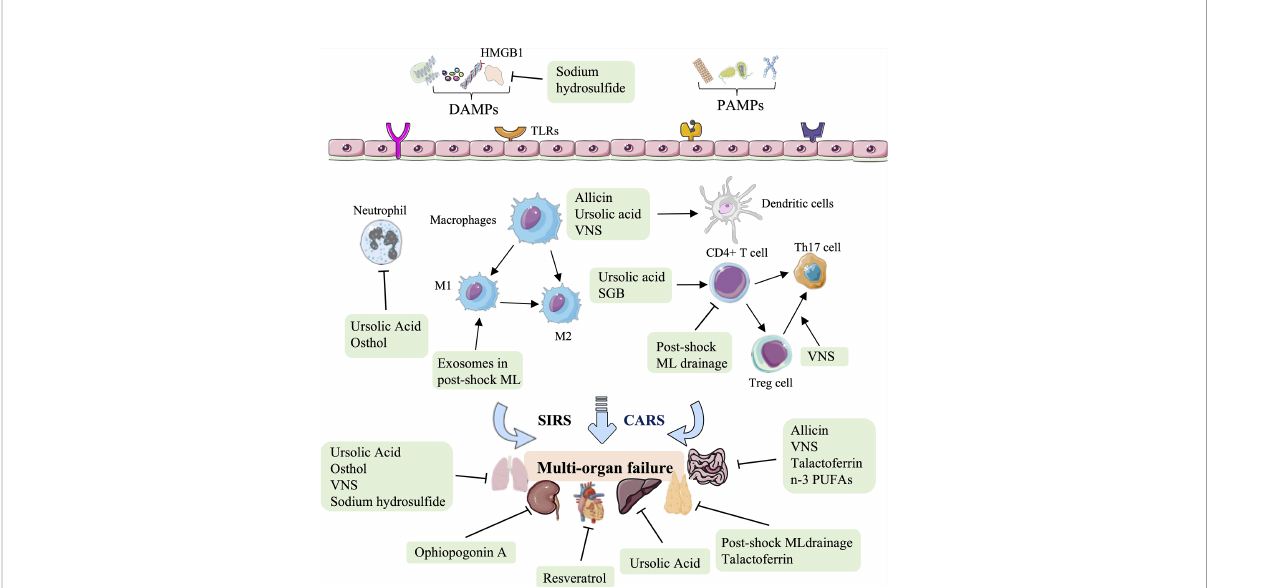
FIGURE 5 Overview of the natural medicine, vagus nerve stimulation, and other therapy approaches in hemorrhagic shock. Natural medicines, such as resveratrol, ophiopogonin A, allicin, ursolic acid, and osthol, act on several immune biological processes against HS-induced cardiac, liver, lung, and kidney injury, mainly rely on the inhibition of in fl ammatory cytokine release, modulating DC maturation and neutrophil-dominated in fl ammation. Other therapeutic approaches to HS, such as post-shock ML drainage, vagus nerve stimulation (VNS), stellate ganglion block (SGB), talactoferrin, n-3 polyunsaturated fatty acids (PUFAs), and hydrogen sul fi de, restore the critical organs (thymus, lung, and gut) mainly by regulating the secretion of in fl ammatory and chemokines, and regulating the proportion of CD4 + T cell, Treg cells, Th17 cells, M1-type macrophages, and DCs.